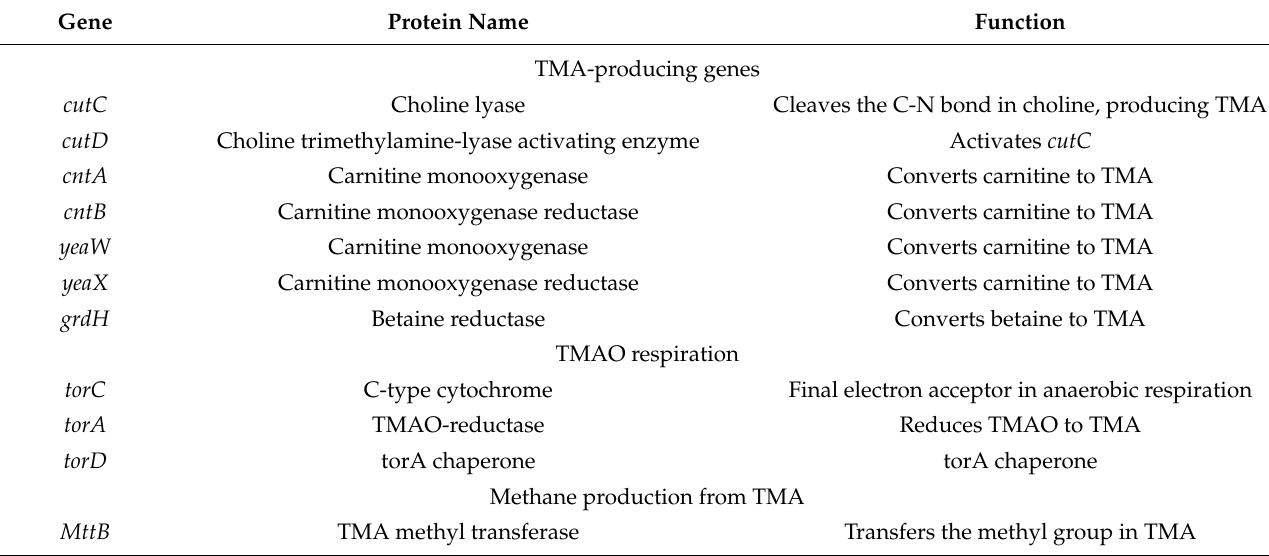
Table 1. Bacterial genes related to TMAO